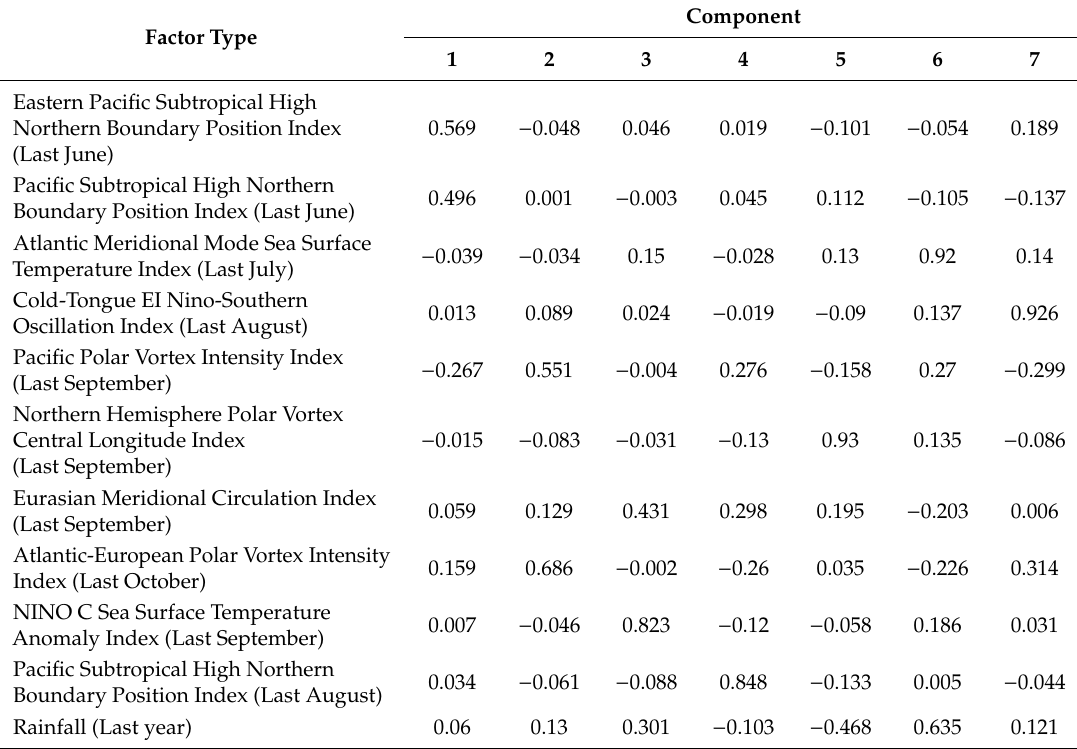
Table 2. Score coe ffi cient matrix of principal components. Factor